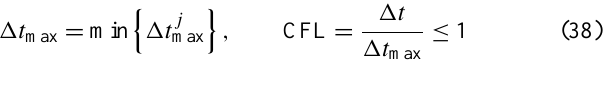
Figure 9. Shockwave propagation in transient mixed flow at t = 100 s (red), t = 200 s (green) and t = 300 s (blue).